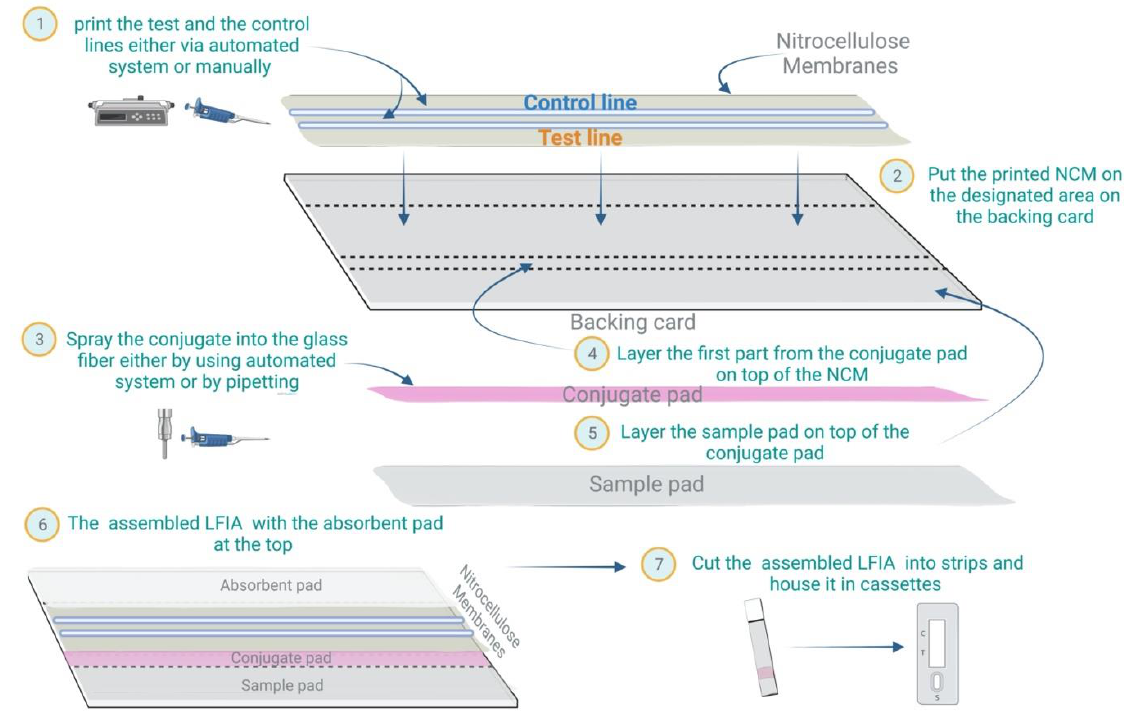
Figure 2. LFIA preparation : Schematic of the general steps for preparing LFIA